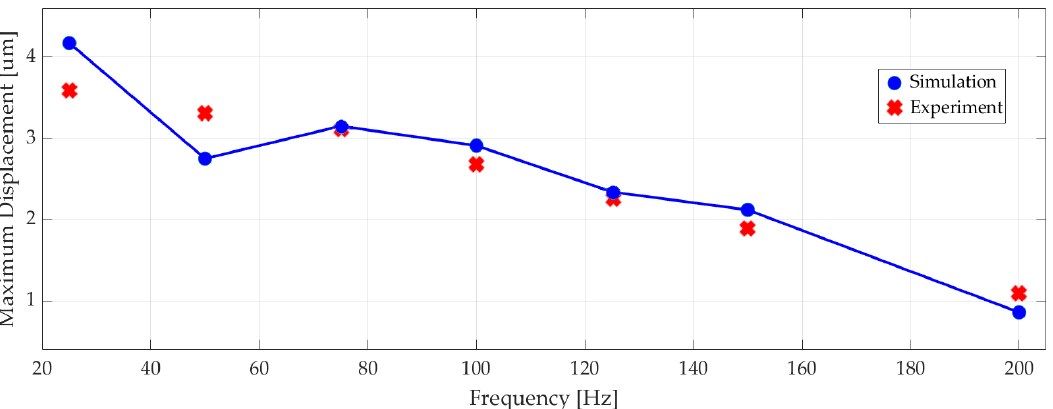
Figure 13. The experimental and simulated maximum displacement of the piezoelectric actuator at different excitation frequencies.